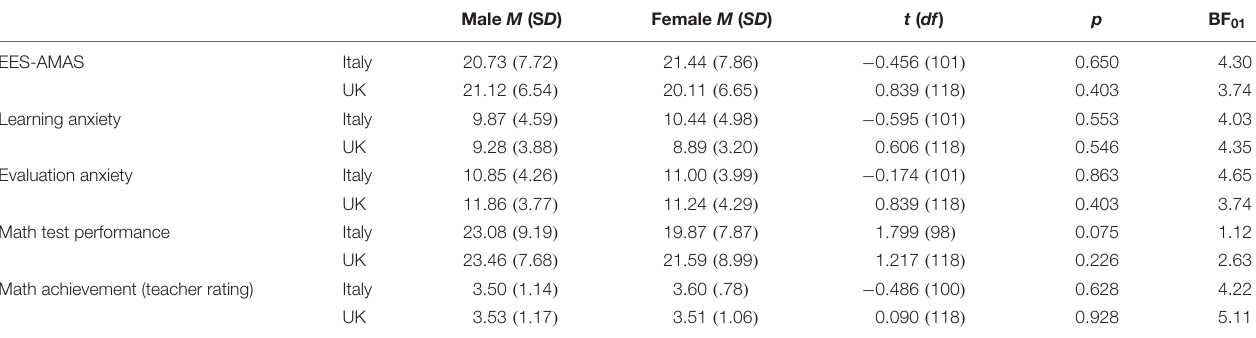
TABLE 7 | Gender differences in math anxiety and math